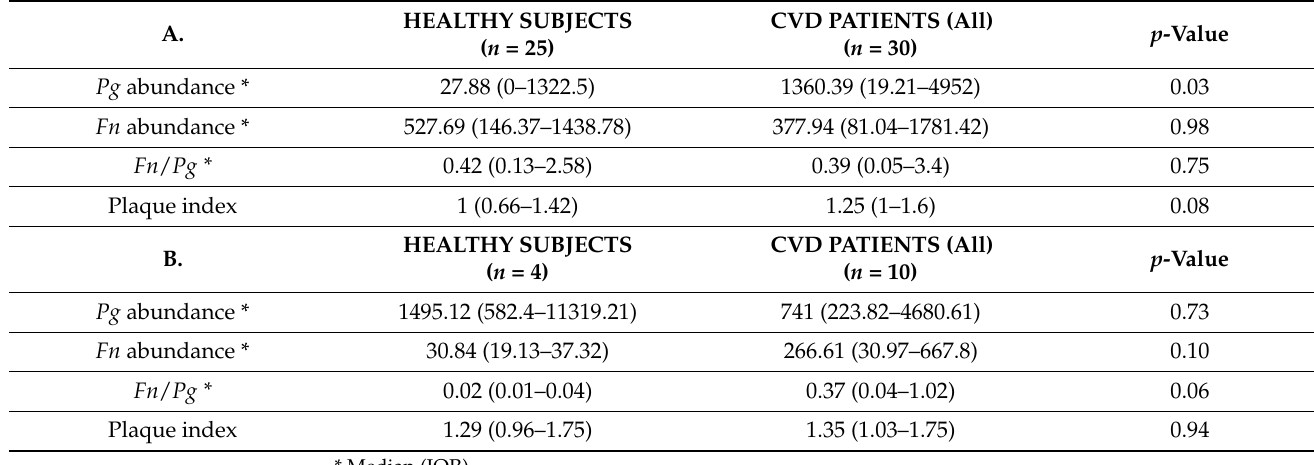
(Figure 1A). In contrast, BMI was negatively correlated with Fn abundance (R = − 0.22, p = 0.028) (Figure 1B). Table 5. Pg and Fn abundance: Comparison between healthy subjects and all patients with previously diagnosed CVD according to BMI less than ( A ) or equal to/greater than ( B ) 30 kg/m 2 .